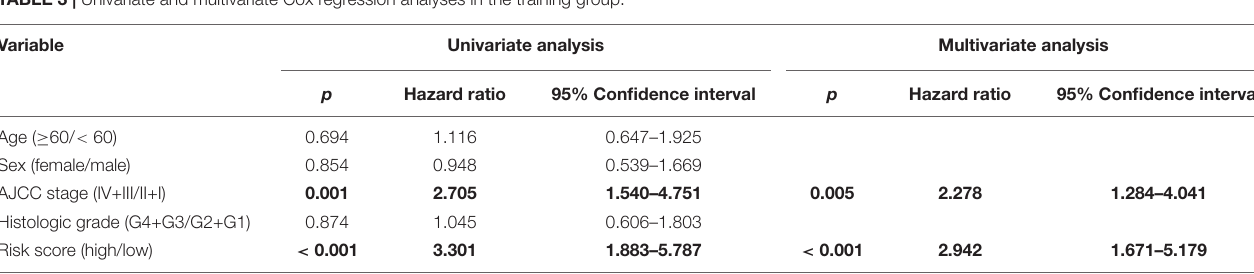
TABLE 3 | Univariate and multivariate Cox regression analyses in the training